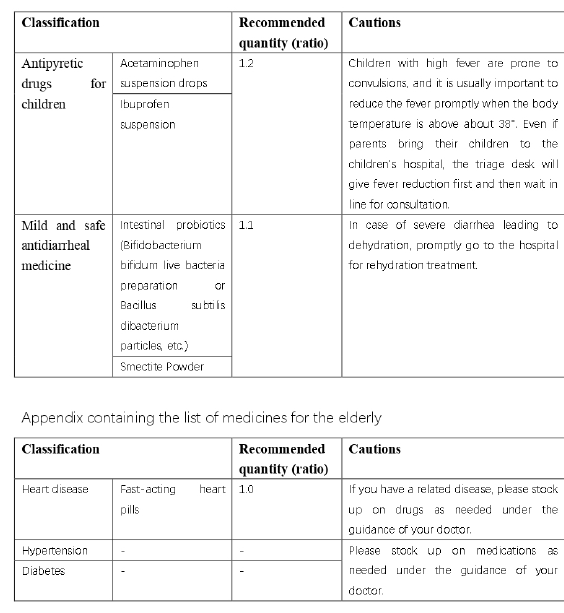
Figure 15. The initial version of the system.